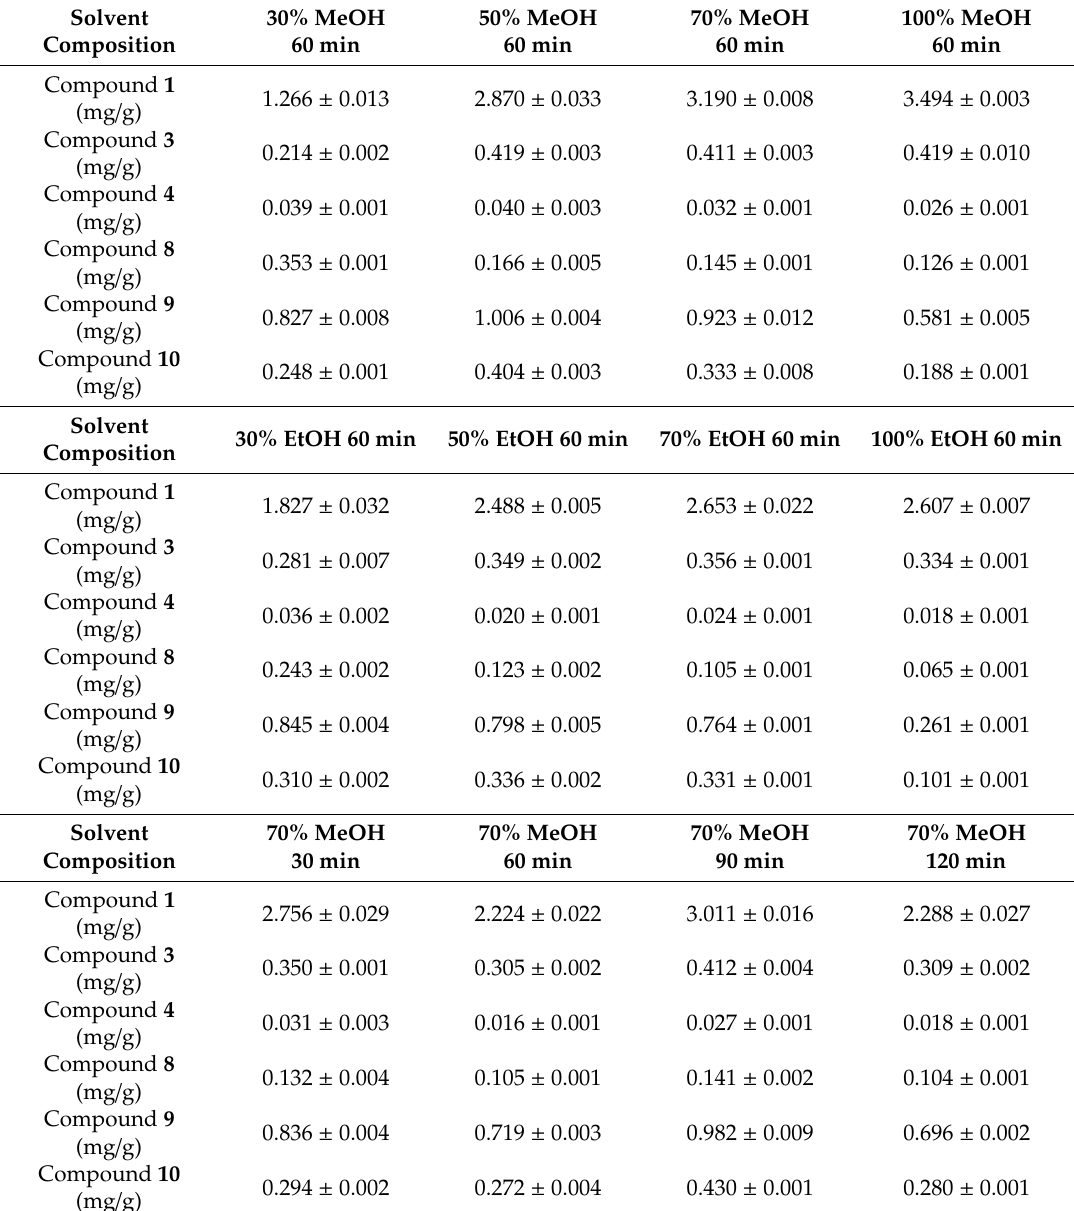
Table 5. Quantity of compounds 1 , 3 , 4 , 8 , 9 , and 10 with reference to various solvent compositions and extraction